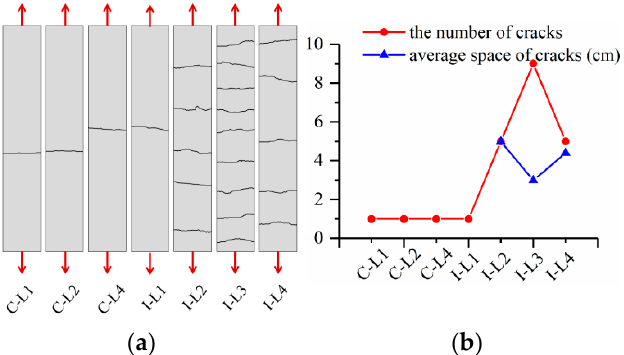
Figure 5. ( a ) crack patterns; and ( b ) number and average spacing of cracks.